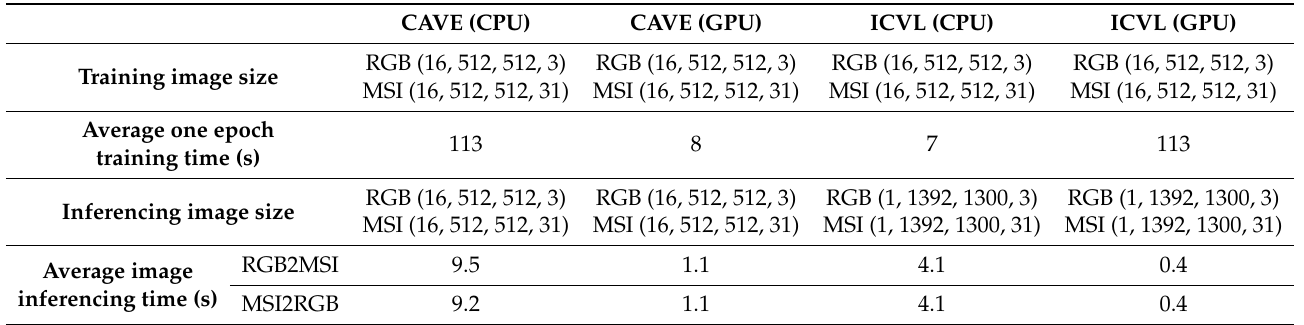
Table A1. The performance summary of TaijiGNN on the CPU and the GPU. (Batchsize = 10,240). CAVE (CPU) CAVE (GPU) ICVL (CPU) ICVL (GPU) Training image